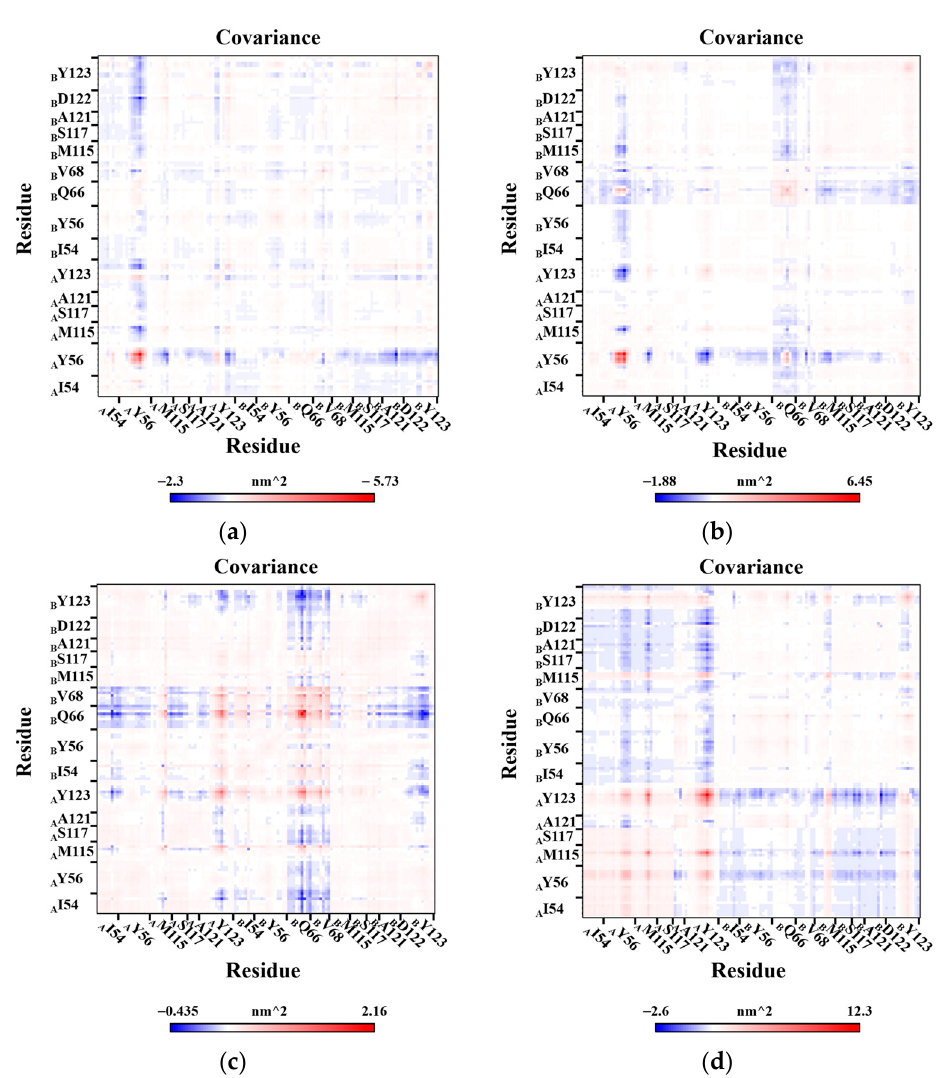
Figure 9. Cross-correlation matrices for the heavy atoms of residues in the binding pocket. ( a ) BMS-200 system. ( b ) MS system. ( c ) MR system. ( d ) Dimer system. The anti-correlated, uncorrelated, and correlated motions among the residues are colored in blue, white, and red, respectively. The color depth on the diagonal of the matrix reflected the motion intensity of the residue itself.